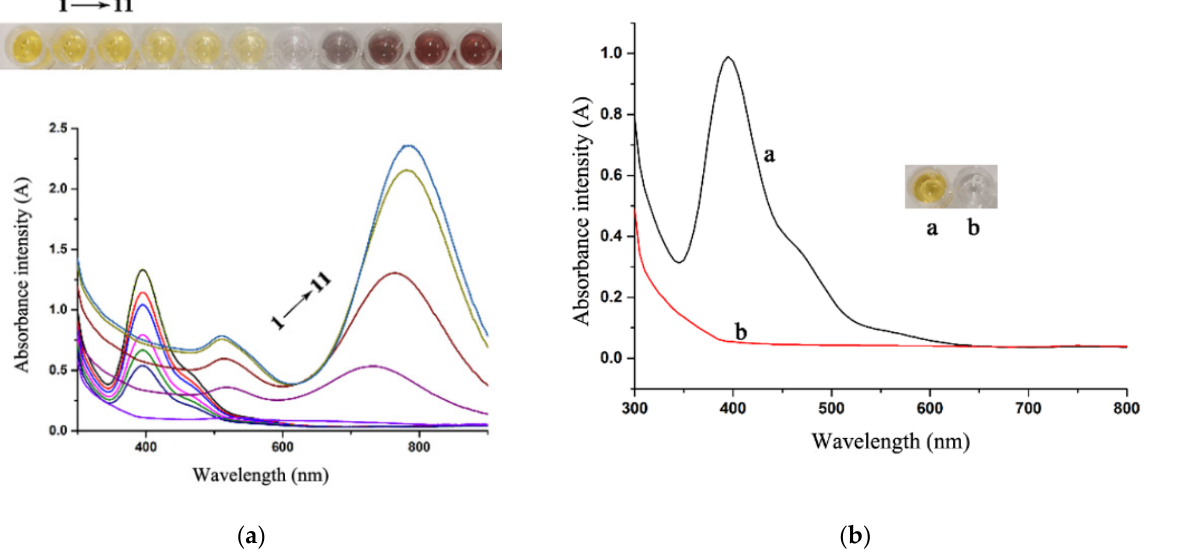
Figure 2. ( a ) UV-visible absorption spectra of AuNRs grown with different volumes of Vc; ( b ) UV-vis spectra and visual results of the AuNRs growth solution before and after adding excessive VcP (a: before; b: after).